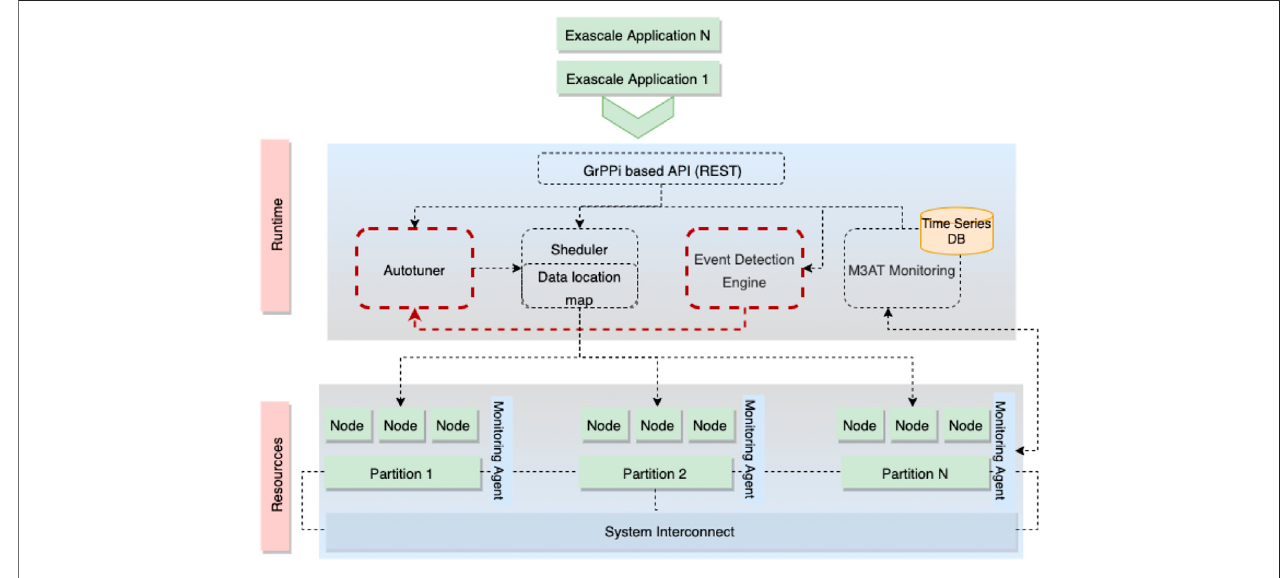
FIGURE 4 | Top view of the ASPIDE system architecture.